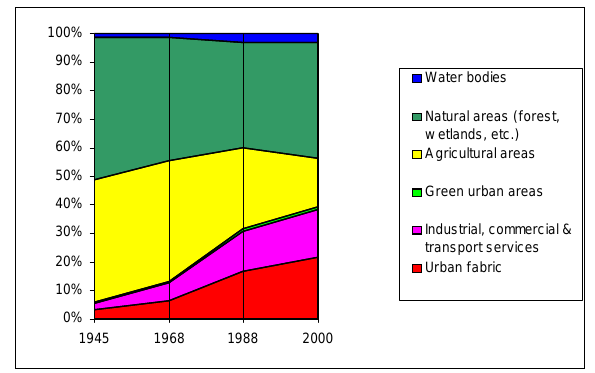
Figure 2: The land-use change by groups of MOLAND Classes.